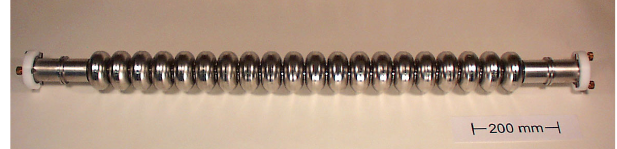
FIG. 1. Photograph of a 20-cell standard SRF cavity used at the S-DALINAC. It is made of bulk niobium and supports a TM 010 ; π resonance at 2.997 GHz.